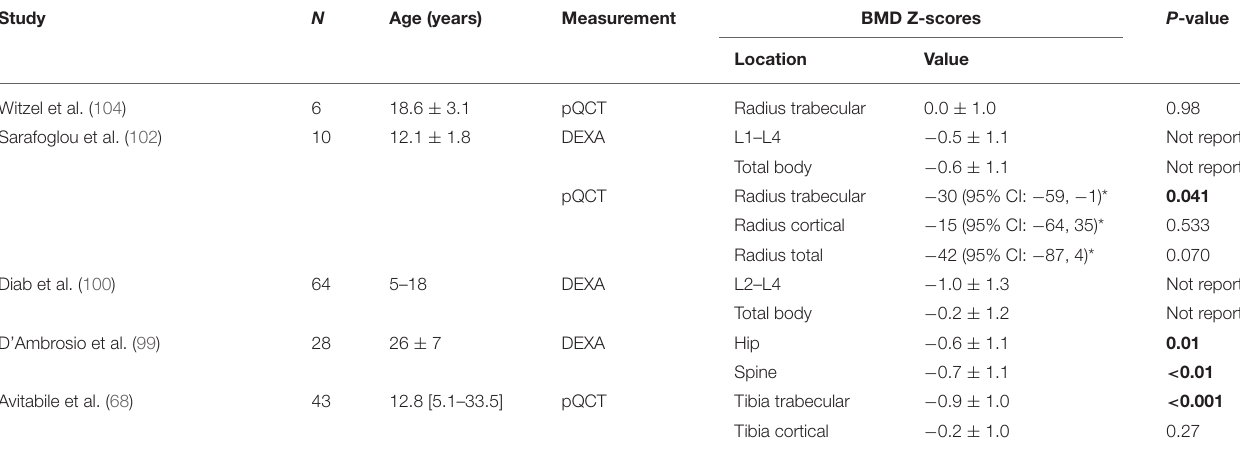
TABLE 2 | Bone mineral density